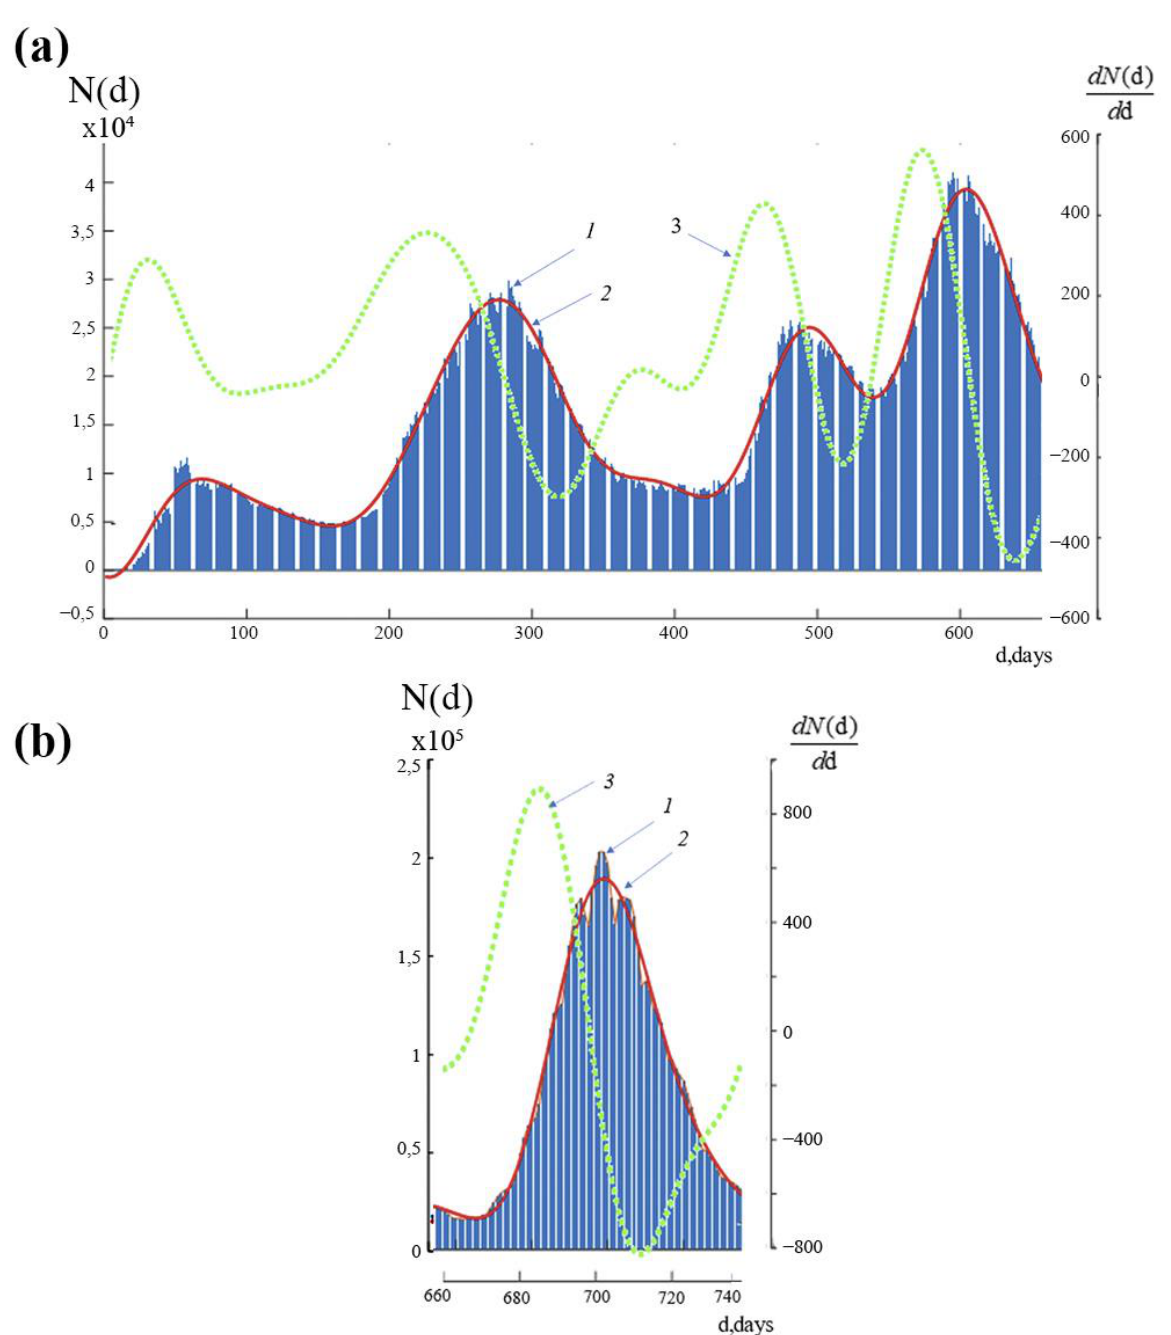
Figure 2. ( a ) — time variance for the daily new number of infections N(d) in Russia within period: 1 day < d < 660 day; 1 — the real dates of new cases of COVID-19; 2 — the average dates of new cases of COVID-19; 3 — the velocity of the average dates of new cases of COVID-19; ( b ) — time variance for the daily new number of infections N(d) in Russia within period: 661 days < d < 738 days; 1 — the real dates of new cases of COVID-19; 2 — the average dates of new cases of COVID-19; 3 — the velocity of the average dates of new cases of COVID-19.